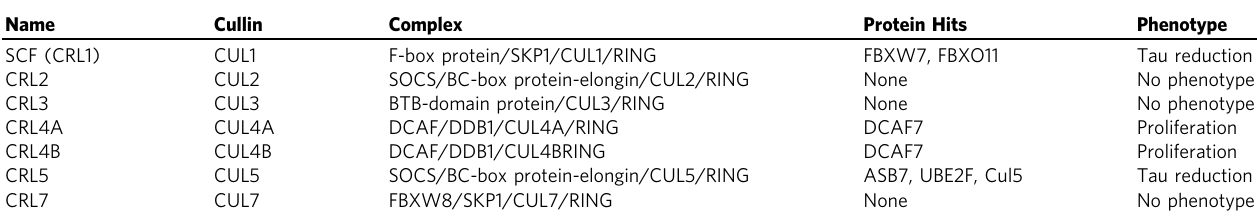
Table 1 CRL1 and CRL5 reduced tau protein